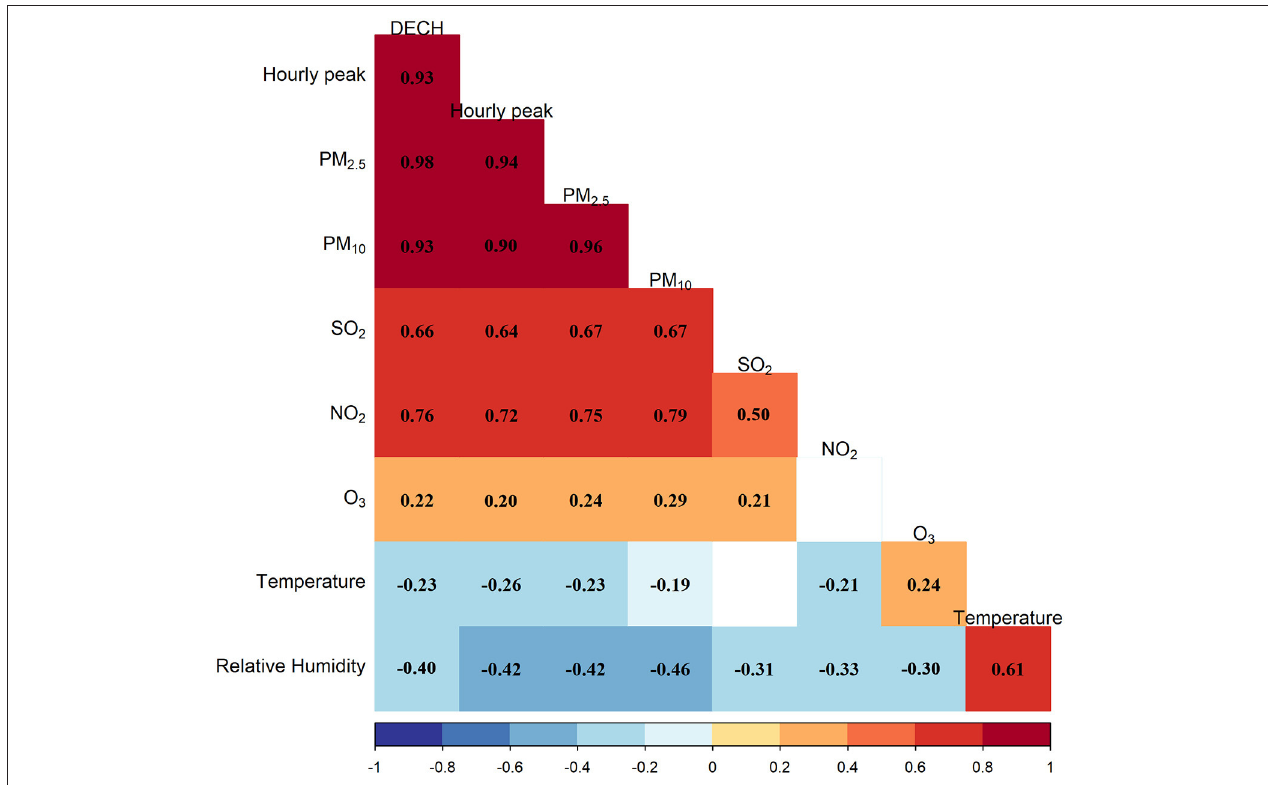
FIGURE 1 | Pearson pairwise correlation plot of ambient air pollutants and meteorological factors.